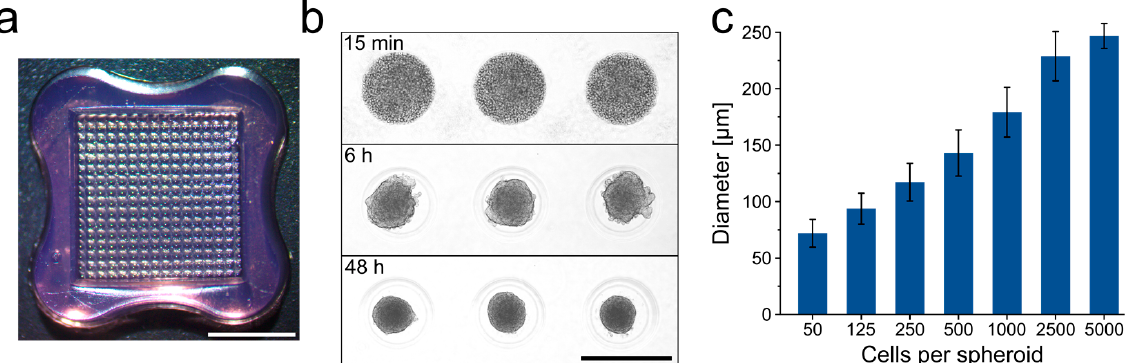
Figure 1. Generation of ASC spheroids in large quantities for 3D bioprinting. ( a ) 3D Petri Dishes ® were applied to obtain agarose molds for the large-scale production of ASC spheroids (256 spheroids/mold). Scale bar represents 5 mm. ( b ) Assembly of ASC spheroids in agarose molds after 15 min, 6 h and 48 h (2500 ASCs/spheroid). Scale bar represents 500 µm. ( c ) Average spheroid diameters as a function of the number of ASCs per spheroid. Data are presented as mean ± standard deviation.